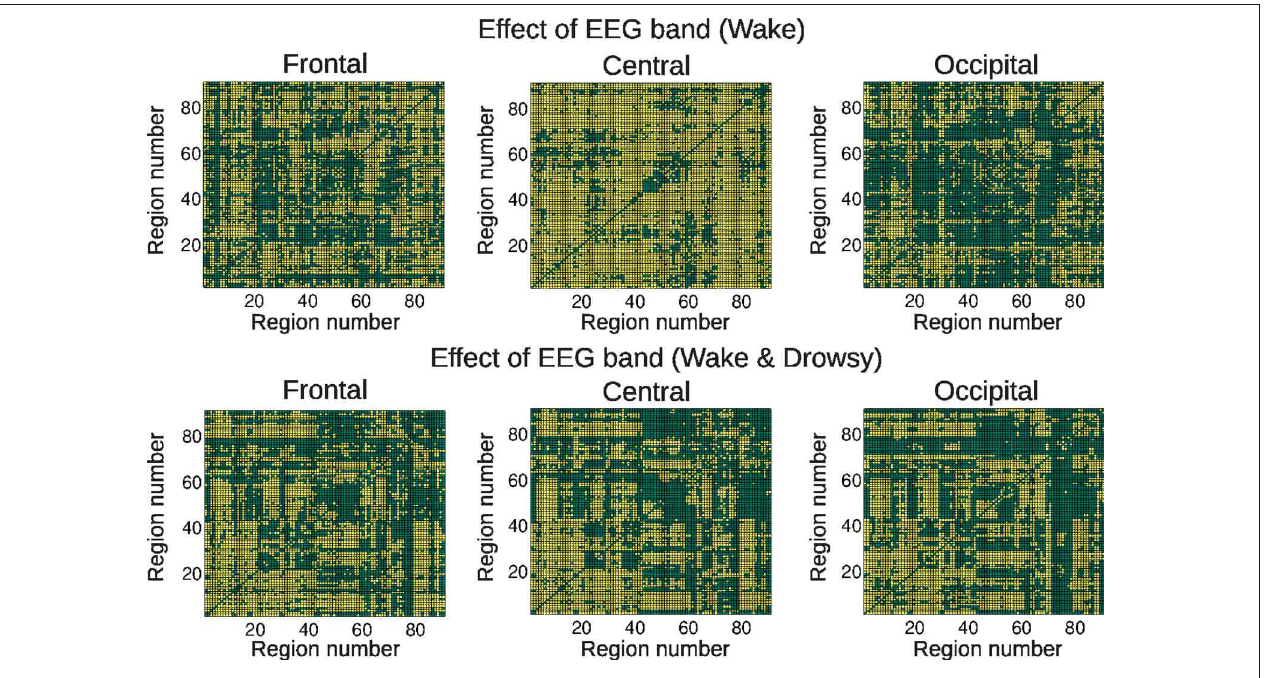
FIGURE 3 | Connections showing a significant (colored in yellow) effect of EEG frequency band in the correlation coefficient between BOLD functional connectivity and spontaneous EEG power fluctuations, for